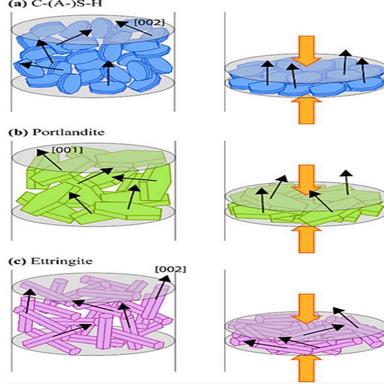
Schematic representation of the development of preferred orientation of (a) C-(A-)S-H, (b) portlandite, and (c) ettringite crystals after compaction. Orange arrows represent compressive load, and black arrows represent the induced or direction. C-(A)-S-H is known to have long-range ordering along the a- and b-axes only. (For interpretation of the references to colour in this figure legend, the reader is referred to the web version of this article.)